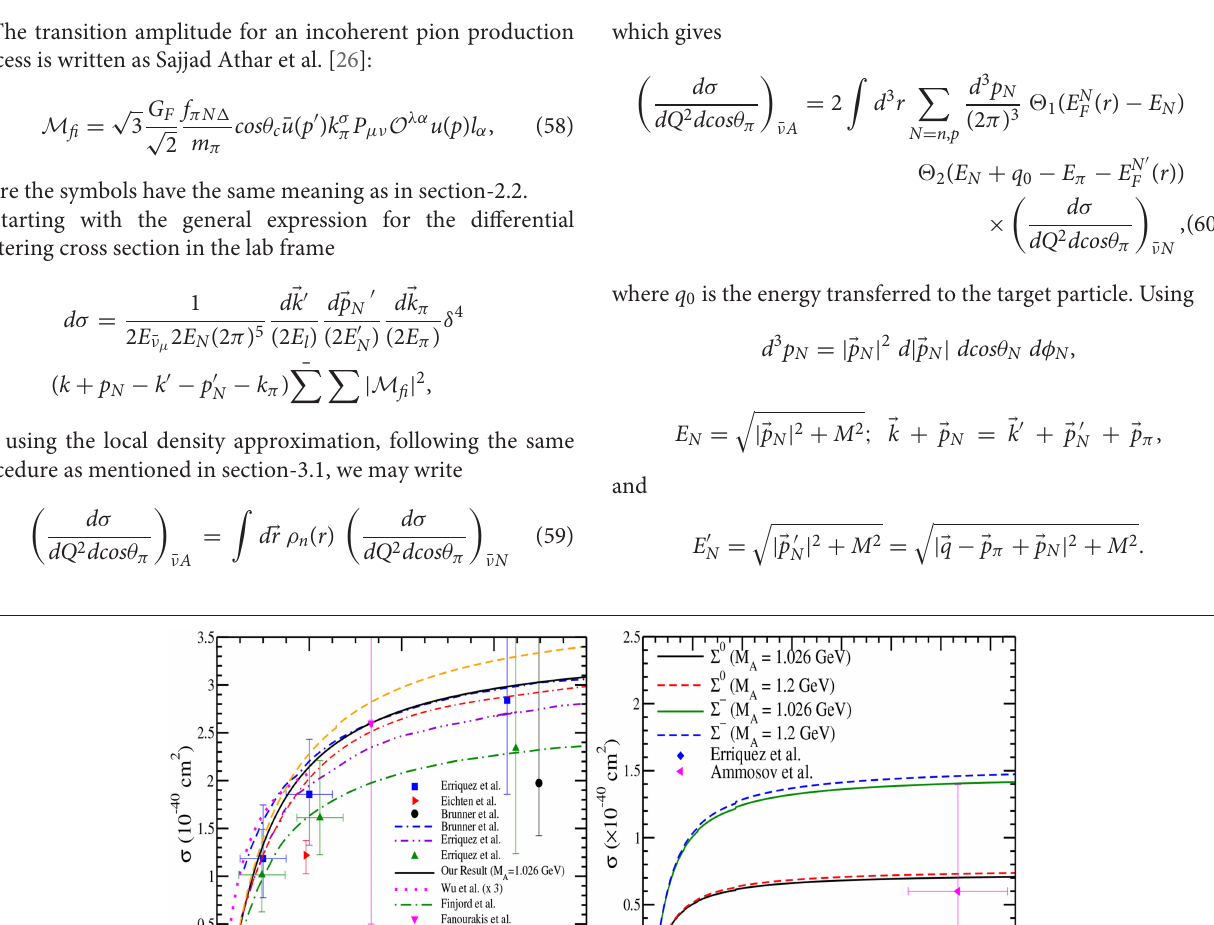
Frontiers in Physics |